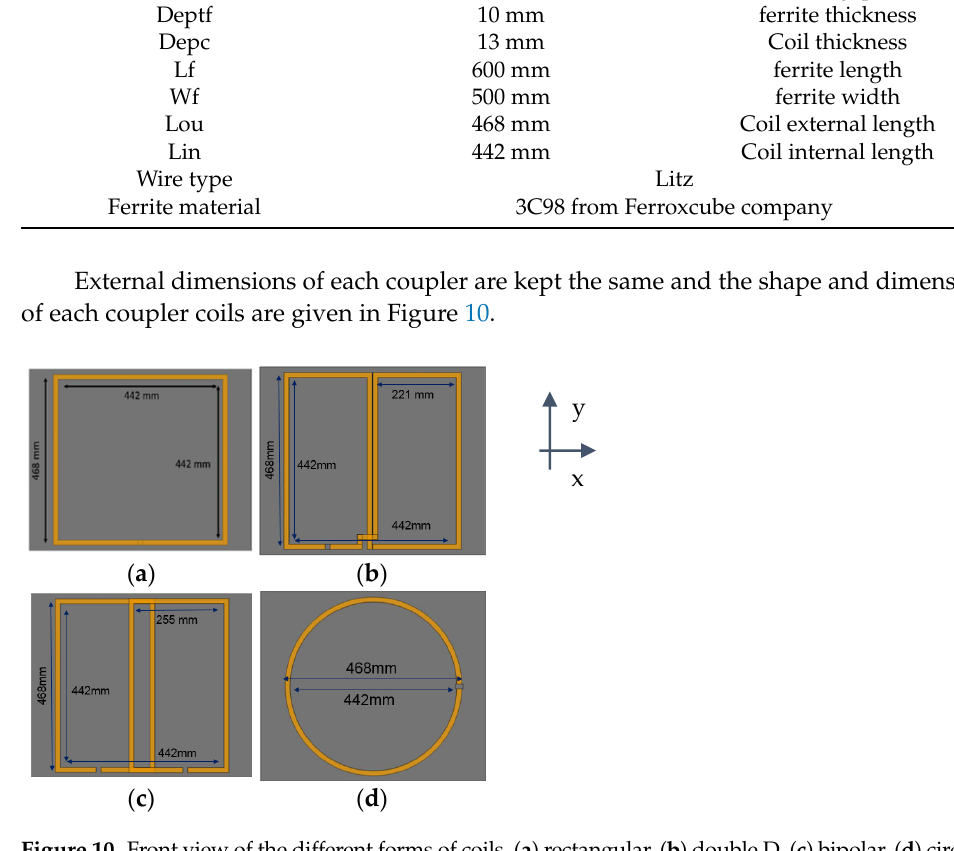
Figure 10. Front view of the different forms of coils, ( a ) rectangular, ( b ) double D, ( c ) bipolar, ( d ) circular.